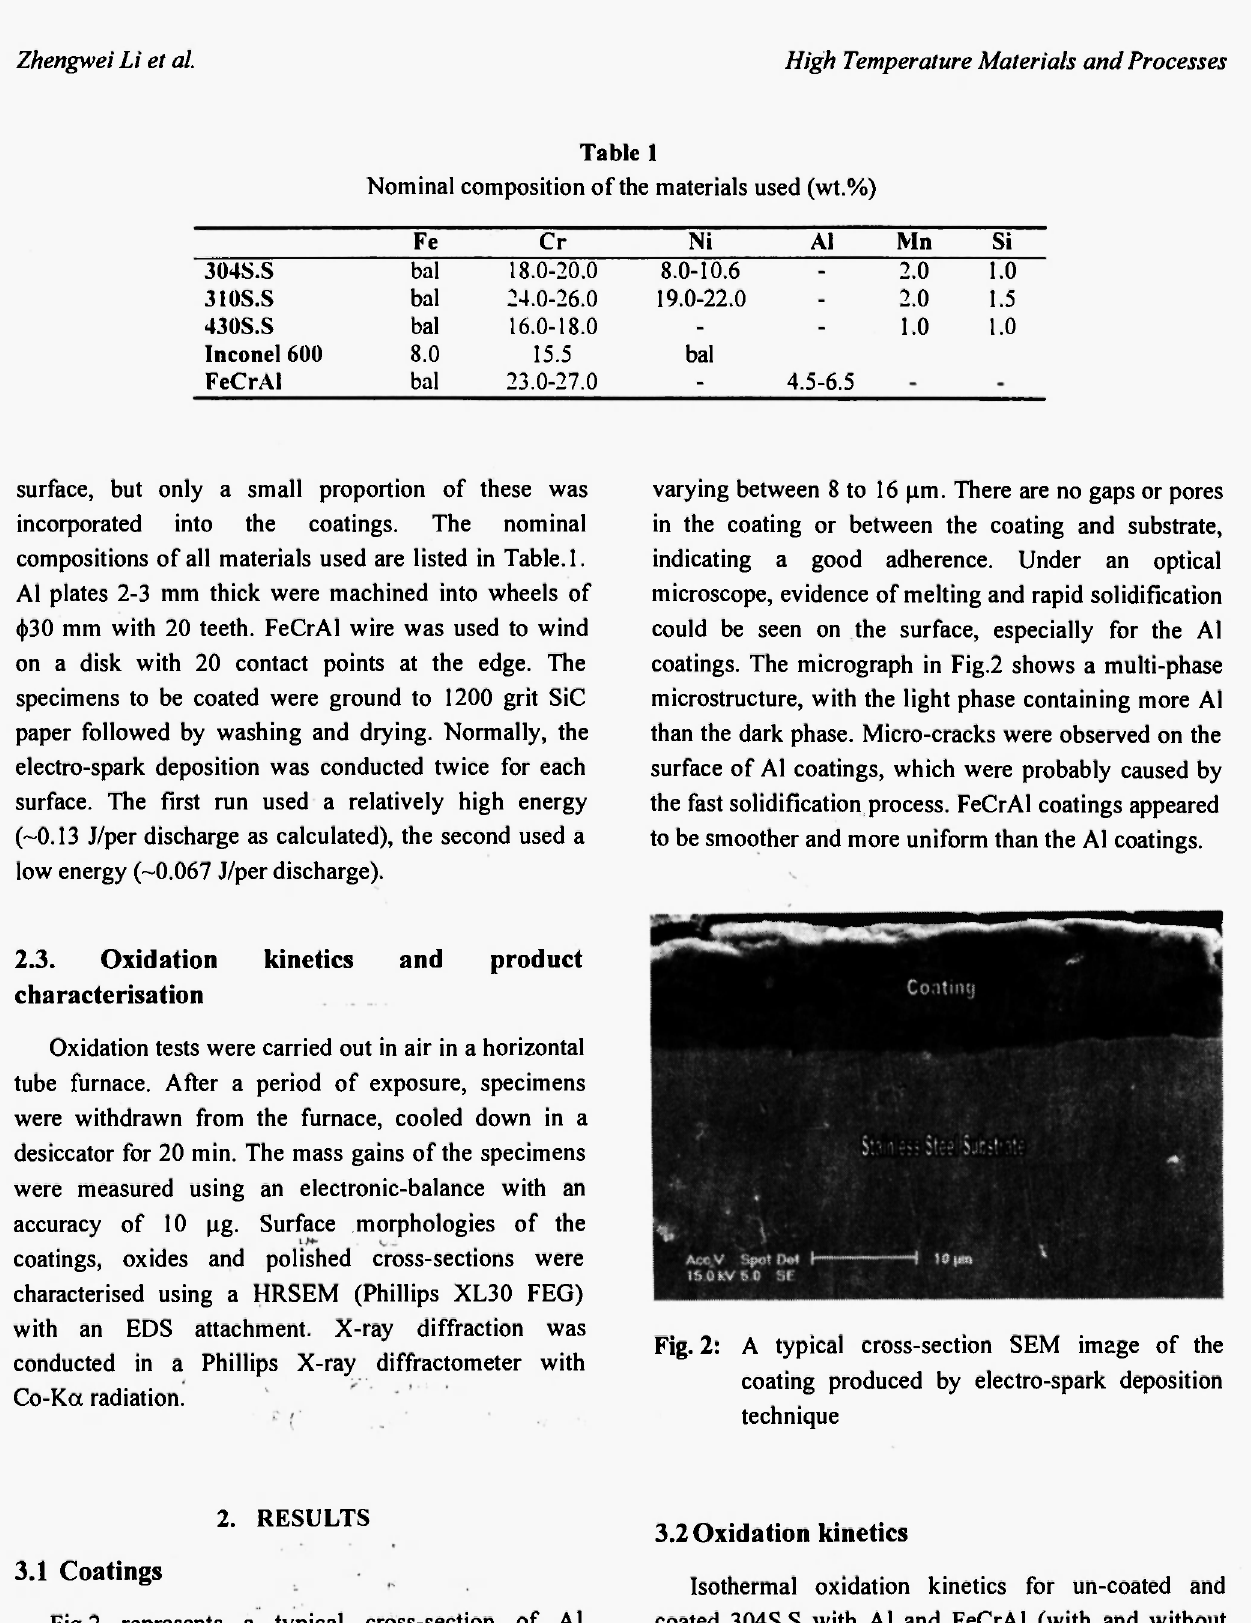
Fig. 2: A typical cross-section SEM image of the coating produced by electro-spark deposition technique